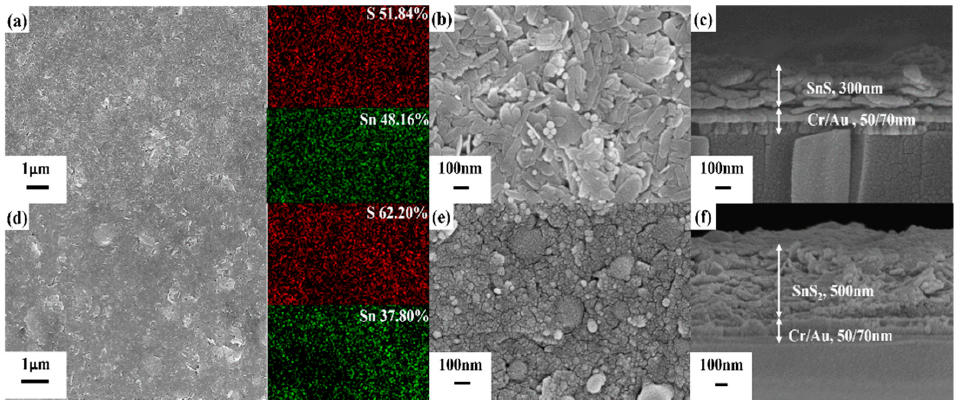
Figure 3. Top and cross sectional SEM image of: ( a – c ) SnS thin films; and ( d – f ) SnS 2 thin films (after sulfurization).